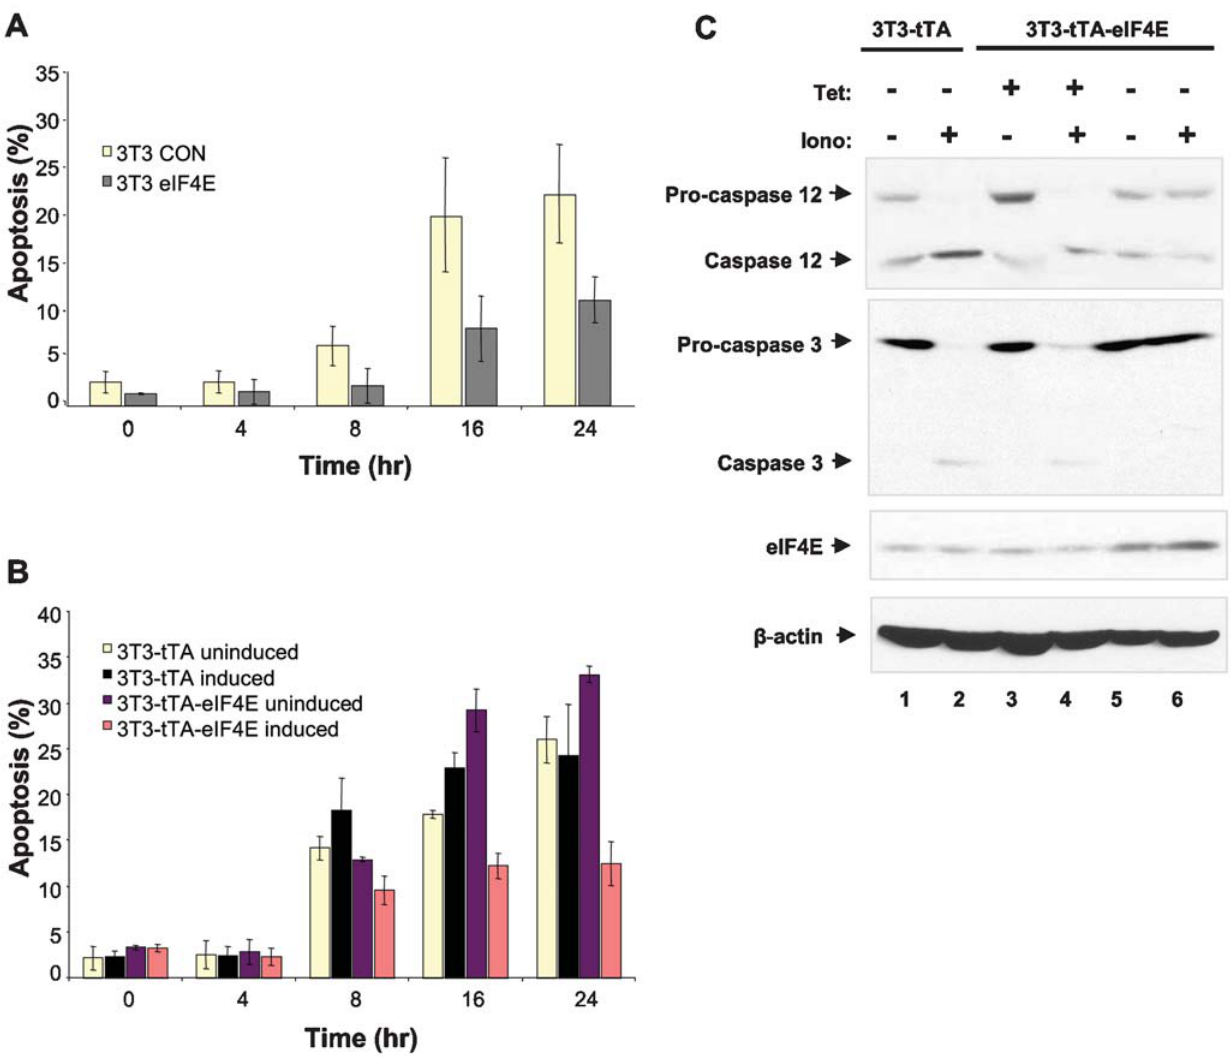
Figure 5. eIF4E induction protects cells against ER-mediated apoptosis. A) 3T3 cells that stably express HA-eIF4E were treated with 5 m M ionomycin for different periods, fixed and stained with propidium iodide. The percentage of apoptosis was quantified by flow cytometry (triplicates were pooled to generate the s.d.) B) 3T3-tTA and 3T3-tTA-eIF4E cells were seeded at 75% confluency and cultured for 8 hr. Tetracycline containing medium was then replaced by a tetracycline free medium for 16 hr to induce eIF4E expression. Uninduced cells were cultured for the same